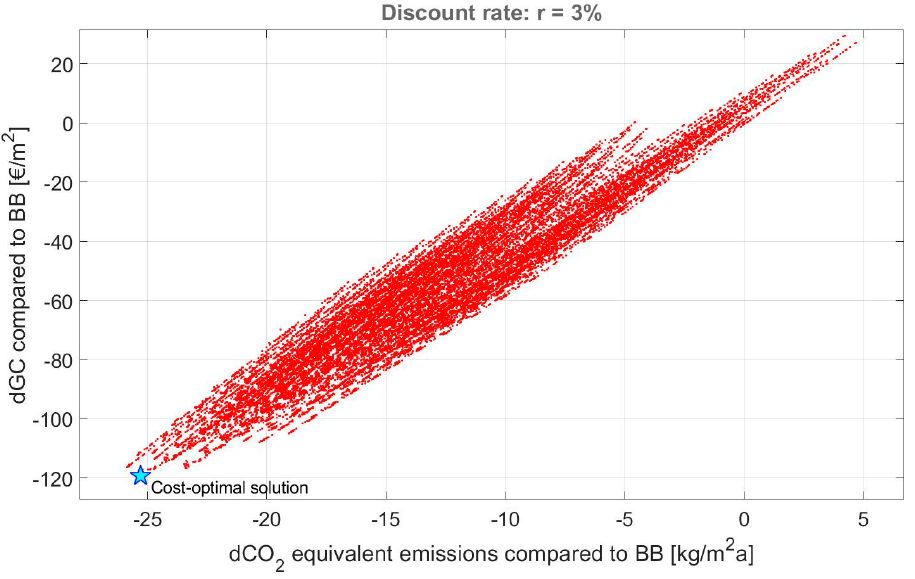
Figure 10. dGC vs dCO 2 -eq emissions for all the investigated energy retrofit scenarios for r = 3%. The cost-optimal solution is highlighted by a bigger marker. The cost-optimal solution is highlighted by a bigger